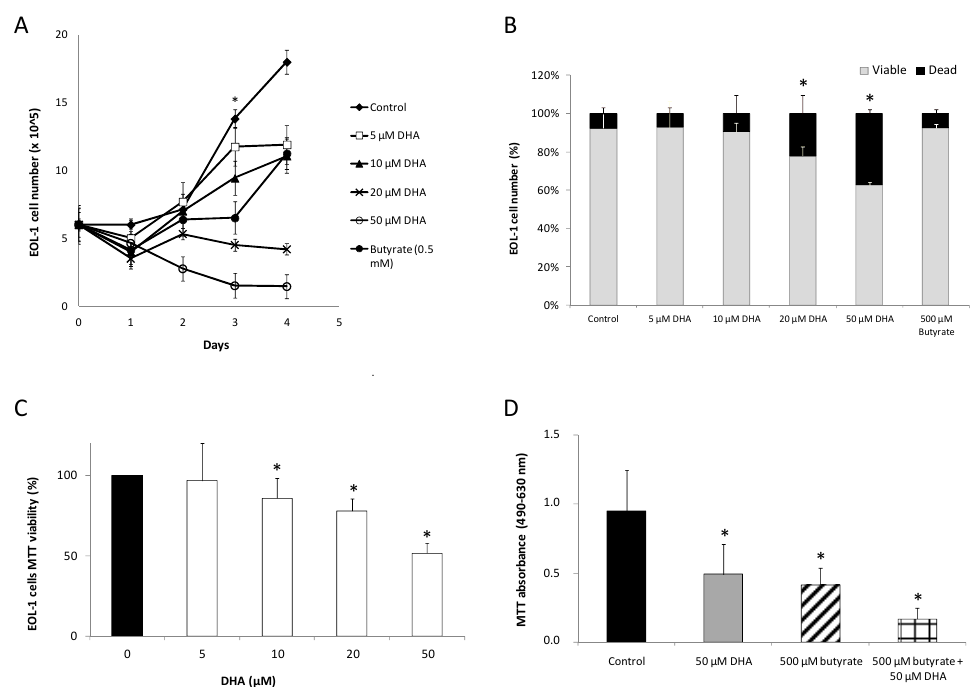
Figure 1. ( A ) Effect of various DHA (docosahexaenoic acid) concentrations on the growth of EoL-1 cells. EoL-1 cells were incubated for the periods indicated at 37 ◦ C/5% CO 2 in the absence or presence of various concentrations of DHA (5, 10, 20, 50 µ M) with 500 µ M butyrate as a positive control. The cells were then collected, stained with trypan blue, and counted. * Statistical significance of p < 0.01 vs. the corresponding control in all DHA concentrations on the third day of growth ( n = 5, in duplicates, t -test analysis for independent samples, Statistica Software). ( B ) Viable to dead cell counting with trypan blue staining. The starting EoL-1 cell culture consisted of 1.5 × 10 6 cells/mL complete medium, and were left to grow for 3 days at 37 ◦ C/5% CO 2 in the absence of DHA (control cells) or presence of 5, 10, 20, 50 µ M DHA or 500 µ M butyrate. Cell counting was performed after 72 h. Values represent the average of the percentage of viable or dead cells number in the medium ± SD. * Statistically significant difference of p < 0.01 versus control ( n = 3 in duplicates, t -test analysis for independent samples, Statistica Software). ( C ) EoL-1 cells viability. Effect of various DHA concentrations (5, 10, 20, 50 µ M) on the viability of EoL-1 cells, measured by MTT assay. The viability of the EOL-1 cells was reduced to 97, 86, 78, and 51% when incubated with 5, 10, 20, and 50 µ M DHA, respectively. Values represent the means ± SD. * Statistical significant difference of p < 0.01 versus control ( n = 3, in duplicates, t -test analysis for independent samples, Statistica Software). ( D ) EoL-1 cells MTT viability in combination with butyrate. Effect of 50 µ M DHA or 500 µ M butyrate or combination of both on the viability of EoL-1 cells, measured by MTT assay. Values represent the means ± SD. * Statistical significant difference of p < 0.01 versus control ( n = 3, in duplicates, t -test analysis for independent samples, Statistica